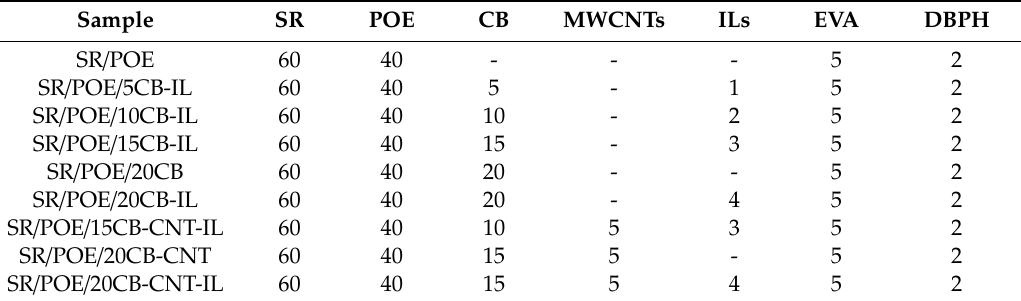
Table 1. Composite compositions (weight